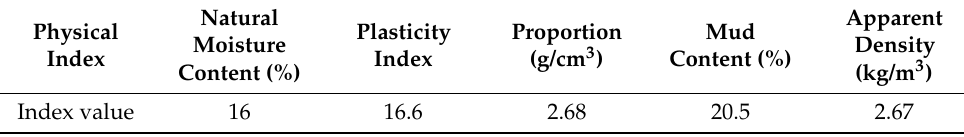
Figure 1. Acquisition process of RA required for test. Table 1. Physical performance indexes of